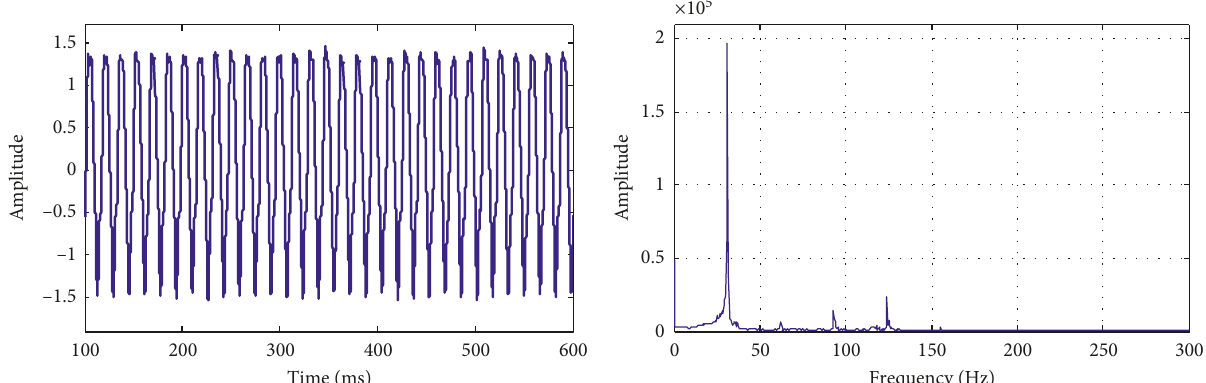
Figure 6: Vertical vibration amplitude signals and its frequency diagram on the disk.